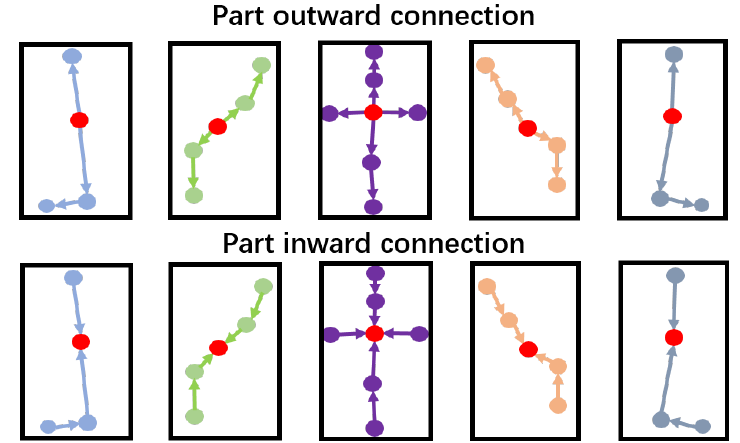
Figure 5. The part outward connection and the part inward connection structure in PGCN. The red joints’ vertexes represent the center joints’ vertexes of each part. The arrow direction indicates the update direction from the source vertex to the target